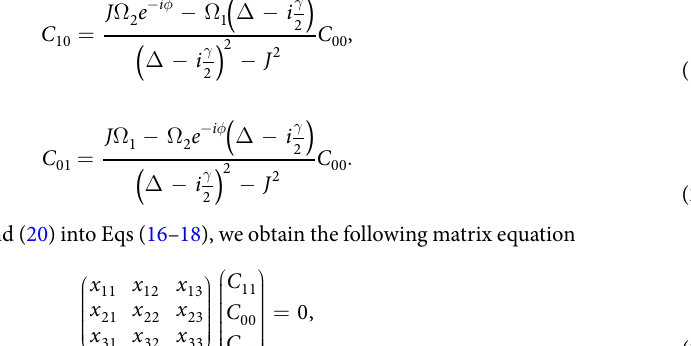
where, the matrix elements are given by